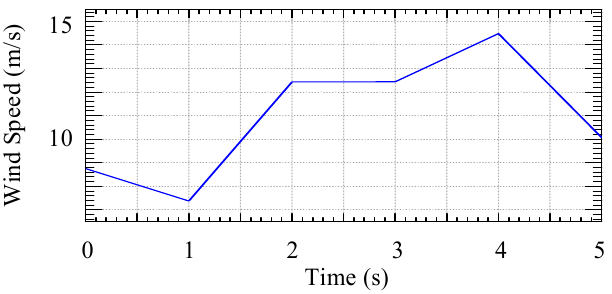
Figure 11. Wind speed fluctuation between 7 m/s and 15 m/s.